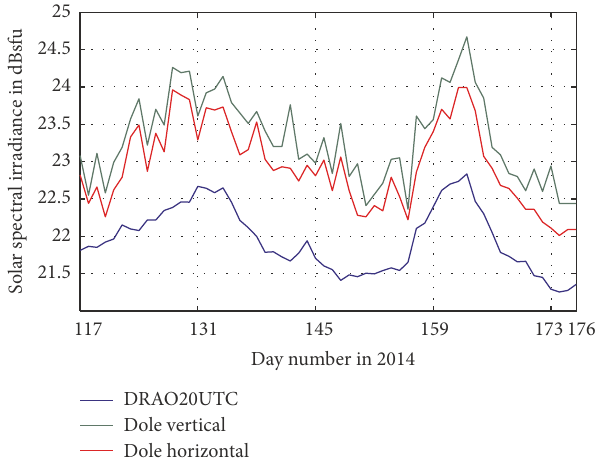
Figure2:Dailyvariabilityoftheverticalandhorizontalpolarization solar radio emission retrieved from the C-band weather radar located at La Dole in Switzerland. The 60-day observation period runs from April 27 to June